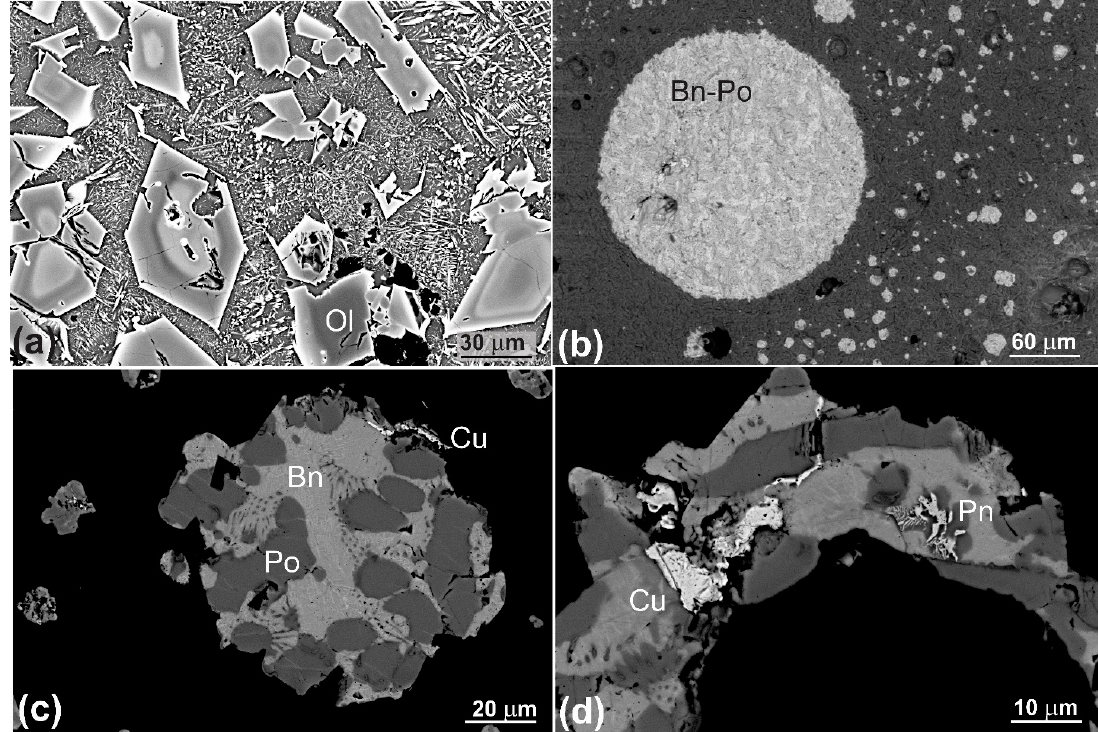
Figure 8. SEM-BSE images of a non-magnetic slag (Figure 2f). ( a ) Zoned prismatic olivine (Ol) crystals, Fe-rich at the rim, in a matrix with olivine dendrites. ( b ) Spherical nodule with bornite (Bn, bright) and pyrrhotite (Po, grey). ( c ) Metallic nodules with pyrrhotite (dark), bornite (grey) and metallic copper (Cu, white). ( d ) Bornite-pyrrhotite nodule with metallic copper (white on left side) and dendritic pentlandite (Pn, FeNiS) on right side.